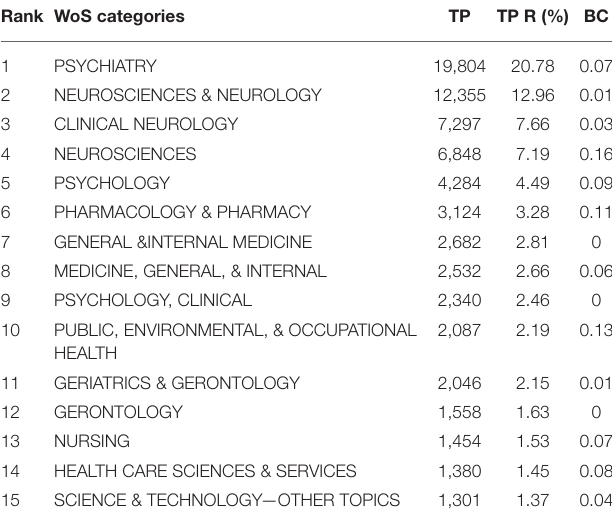
TABLE 3 | The top 15 productive categories,